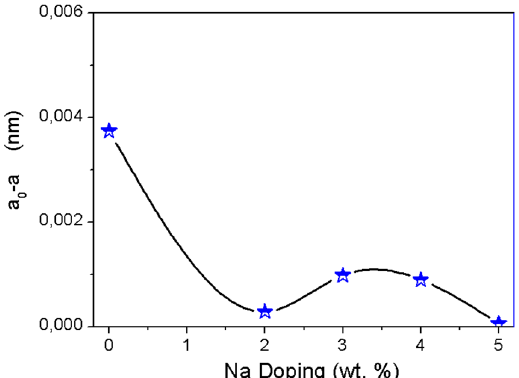
-a of (111) peak in Na doped NiO Figure 2. The Variation of a 0 thin films as a function of doping level. In order to study the crystalline structure, the crystallite size G of (111) plane was calculated by the full width at half- maximum (FWHM) and diffraction peak of (111) plane of Na doped NiO films, as calculated by Scherer's equation 16 : . (2) cos